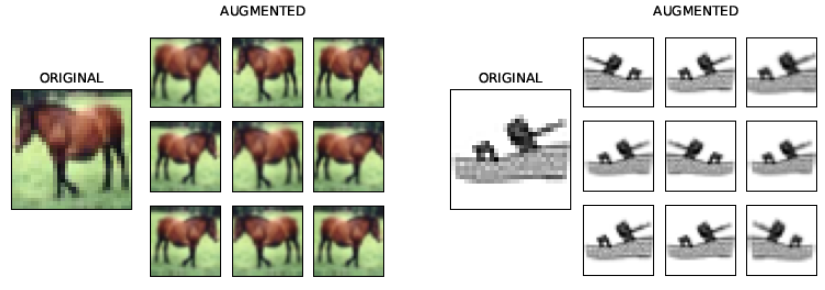
Figure 16. Examples of augmented images.